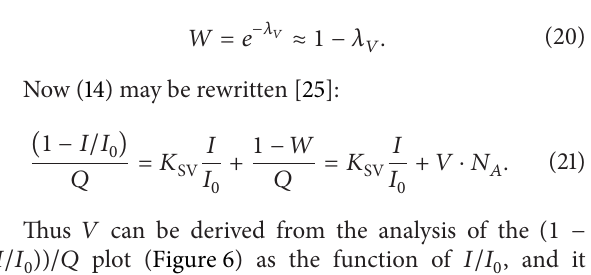
From (14) and (18), we get Table 1: Comparison of the constants derived from the sphere of